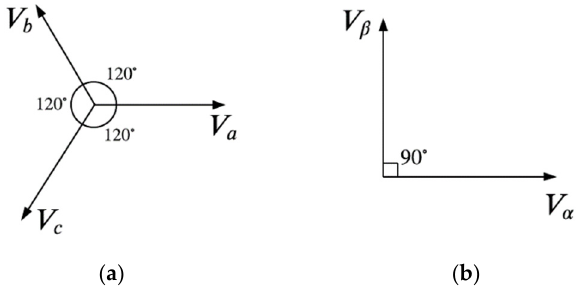
Figure 2. Clarke transformation [28]: ( a ) 𝑎𝑏𝑐 representation and ( b ) 𝛼𝛽 representation. The three-phase voltages of a balanced network are given by Equation (1):